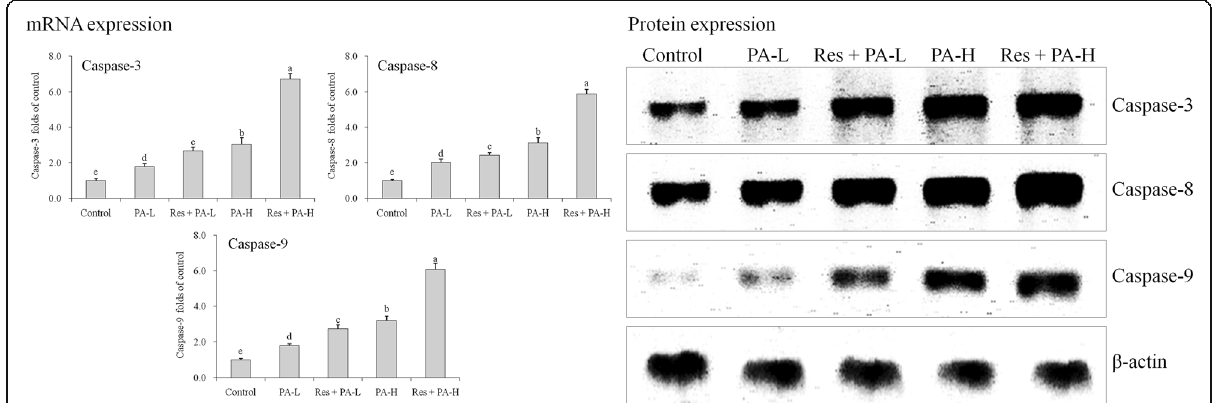
Fig. 4 The mRNA and protein expression of caspase-3 caspase-8 and caspase-9 in HepG2 human liver cancer cells. a-e Mean values with different letters over the bars are significantly different ( P < 0.05) according to Dunnett ’ s post-hoc test. PA-L: 5 μ g/mL of paclitaxel; Res + PA-L: 10 μ g/mL